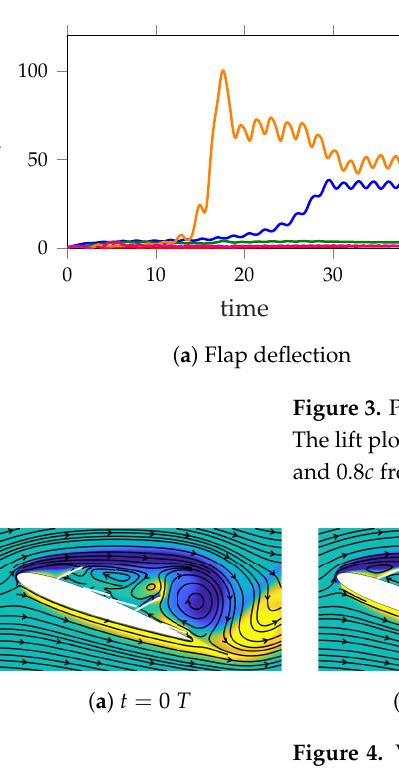
Figure 5. Vorticity contours at different time instants in one period of lift cycle for the flap-less airfoil case.